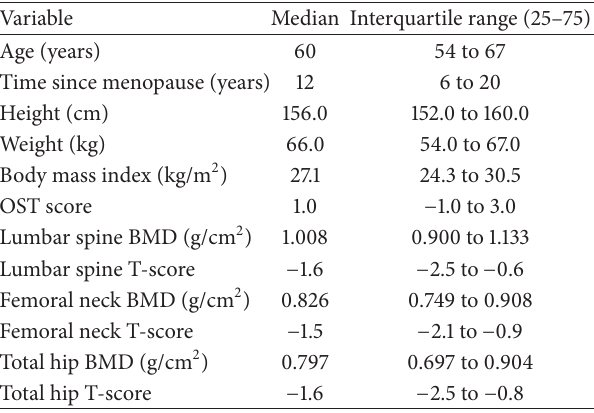
Table 1: Characteristics of participants ( 𝑁 = 4343 ).